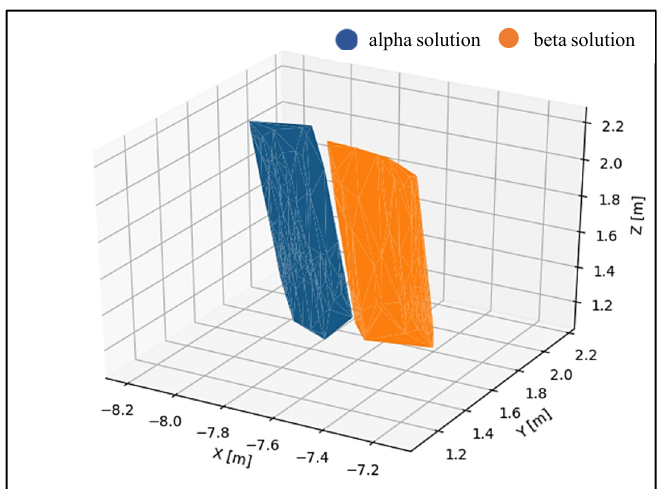
Figure 9. Concrete slabs of a retaining wall (Msplit fitting result).